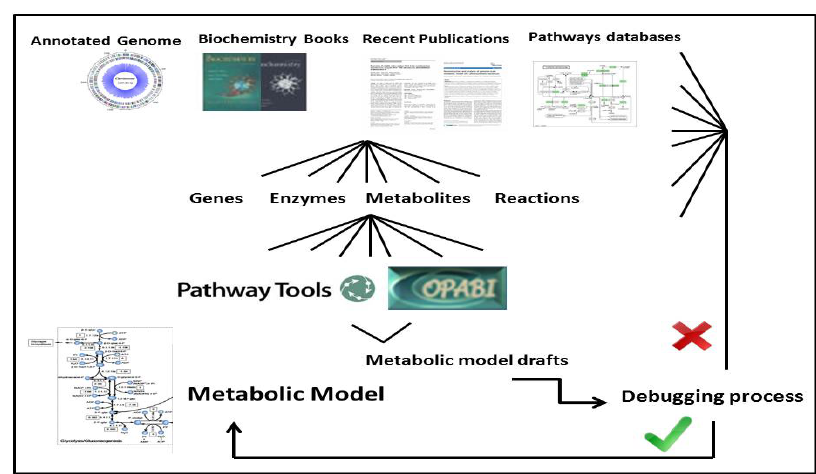
Figure 1. Genome-scale metabolic reconstruction